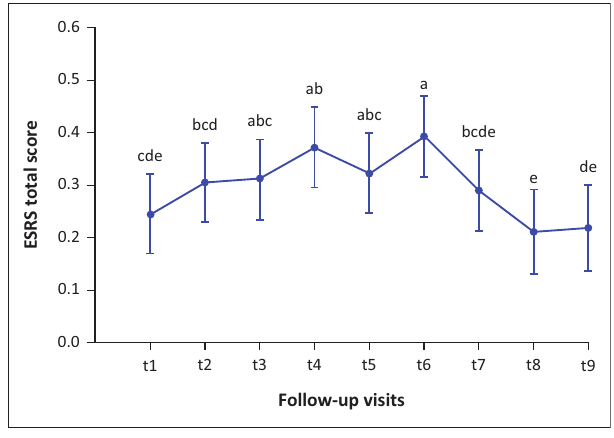
FIG URE 1: Total Extrapyramidal Symptom Rating Scale scores over 12 months of follow-up, displayed as least square means.